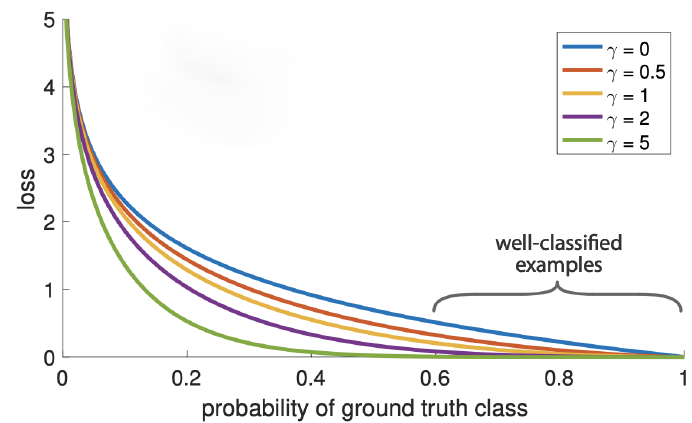
Figure 6. Illustration of the Focal Loss. This figure is from